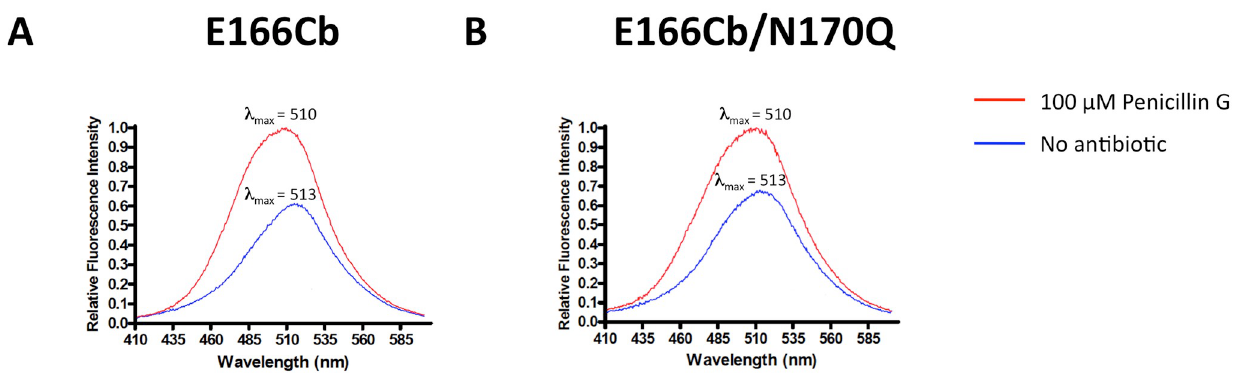
Fig 1. Fluorescence scanning of BADAN-conjugated β -lactamases, (A) E166Cb and (B) E166Cb/N170Q. Spectra were obtained by scanning 0.1 μ M labeled enzyme in 50 mM potassium phosphate buffer (pH 7.0) with an excitation at 380 nm. Blue line: enzyme without penicillin G; Red line: enzyme with the addition of 100 μ M penicillin G.